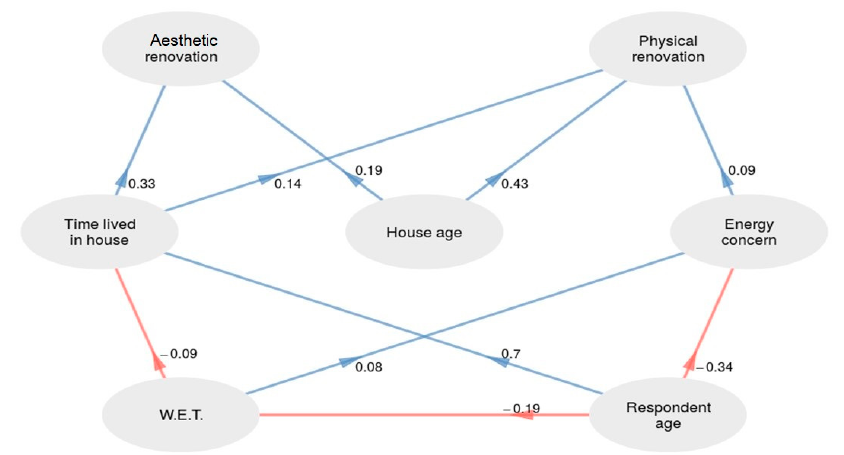
Figure 5. Path coefficients for the physical vs. aesthetic renovation model (significant paths